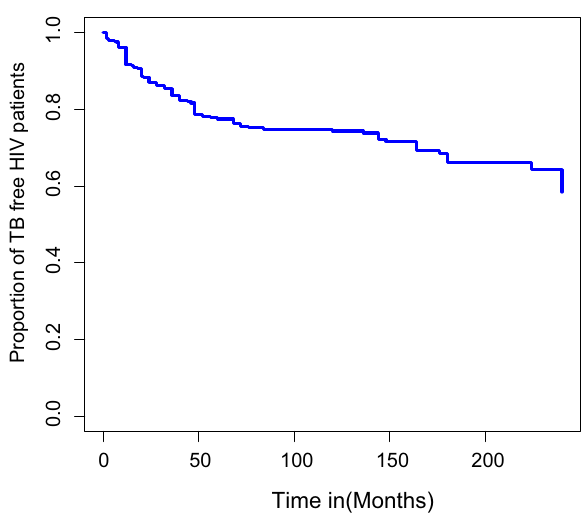
Figure 1. The overall Kaplan-Meier survival curve estimate of TB free co-infection survival time of HIV/AIDS patients.